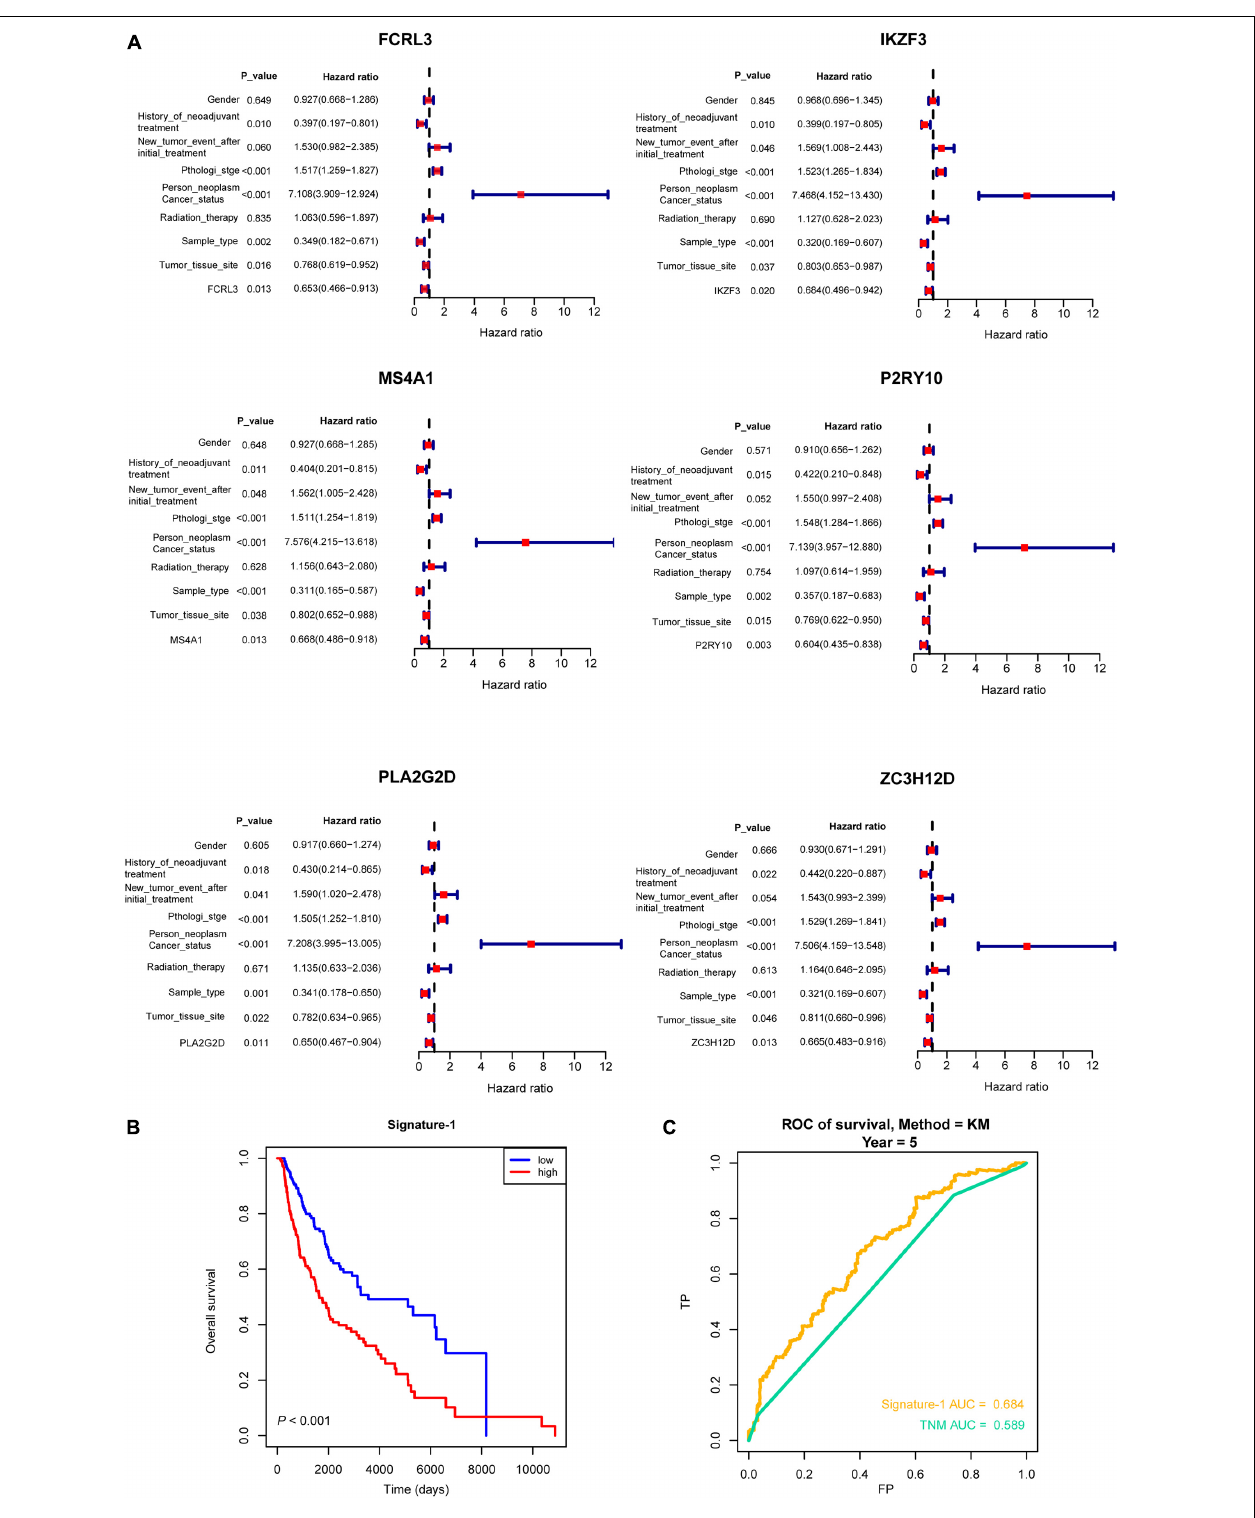
FIGURE 6 | Multivariable Cox regression analysis of crucial genes. (A) Forest plot showing the six hub genes (PLA2G2D, IKZF3, MS4A1, ZC3H12D, FCRL3, and P2RY10) that were independent prognostic factors in skin cutaneous melanoma. (B) The survival model (Signature-1) constructed by the six genes and the Kaplan–Meier curve which showed that it was survival-associated. (C) Receiver operating characteristic analysis showing that Signature-1 performed a better prognostic efficacy than the TNM stage.